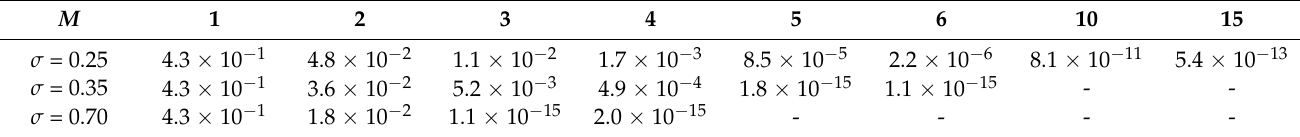
Table 5. The MAE and the computational time versus the M at t = 1.